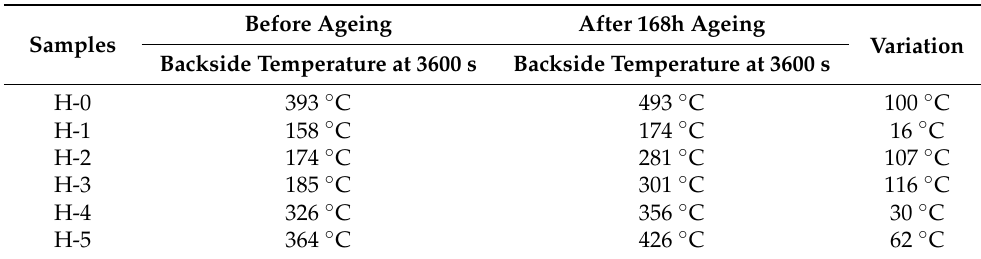
Figure 12. Backside temperature curve of fire-resistant glass with methacrylic acid-acrylamide hydrogel interlayer after accelerate ageing test. Table 3. Backside temperature changes of transparent flame-retarded hydrogel sandwich fire-resistant glass before and after ageing treatment.